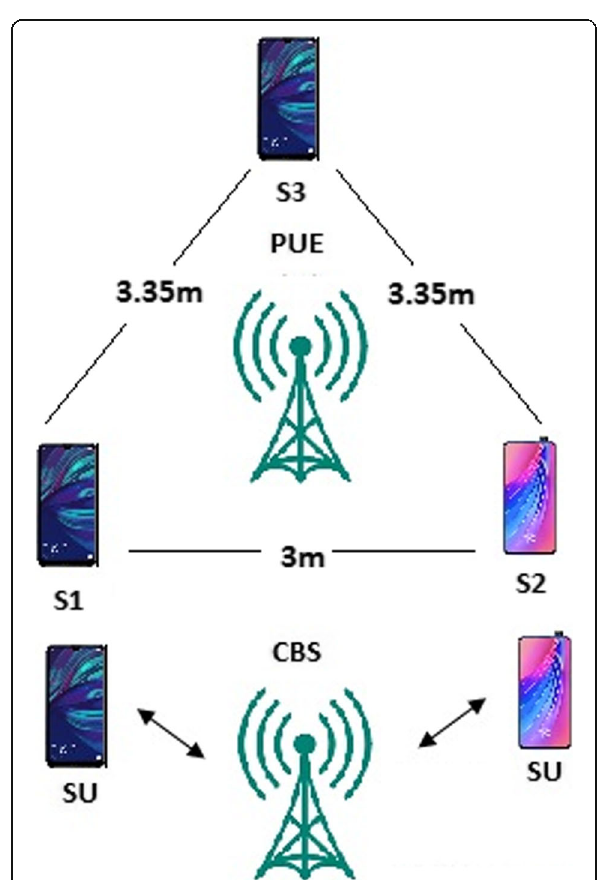
Fig. 5 Proposed motion detection system